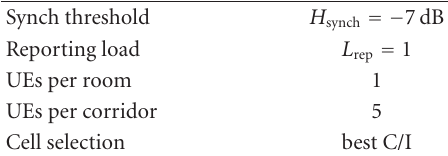
Table 2: Neighbor relation